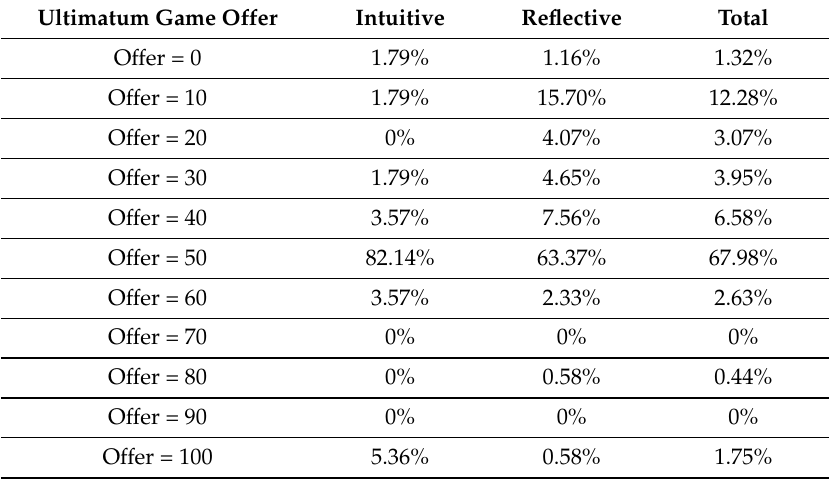
Table A2. Frequency of Ultimatum Game Offer by Intuitive (Reflective)